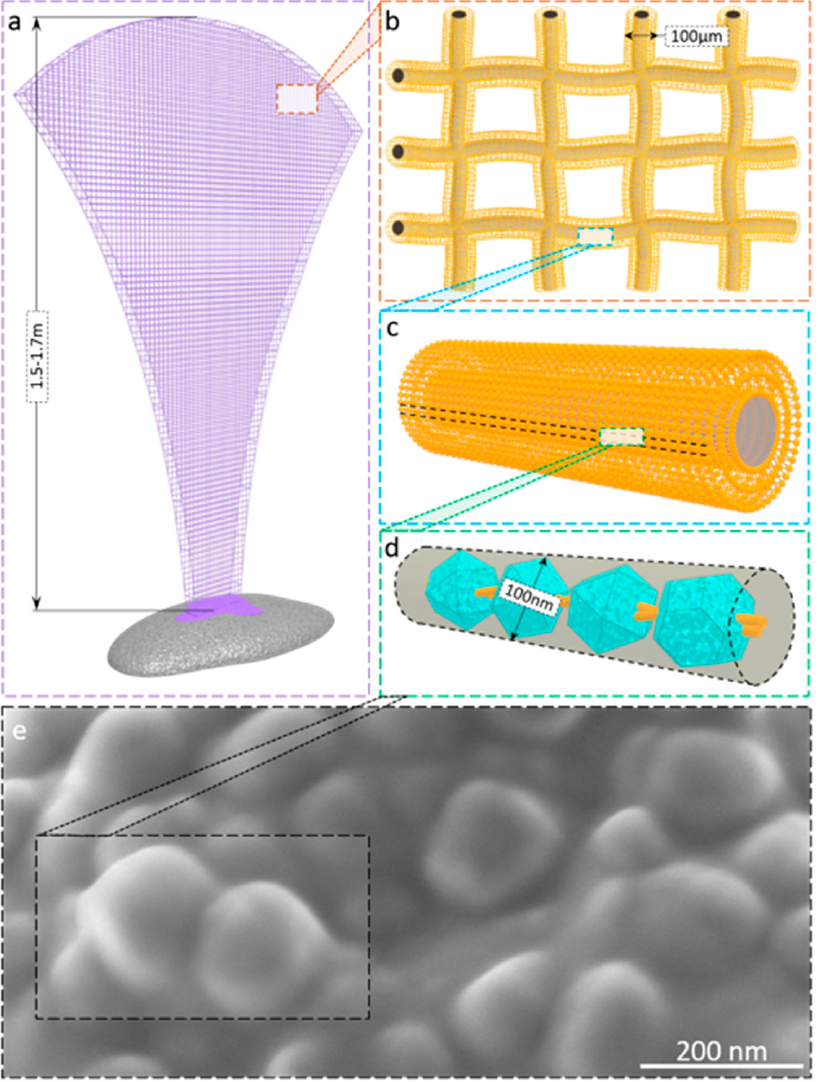
Figure 10. Schematic representation of mineralized giant network-like skeleton of I. basta marine demosponge ( a ). The flat construct is made of highly organized intercalated meshes of microfibers with a diameter of 100 µ m ( b ). These fibers are made of nanostructured chitin ( c ) that plays the role of template for the formation of calcitic nanocrystals ( d ), which remains well visible using SEM ( e ). The origin of calcium that is necessary for the formation of calcite in our case is unclear. It could be from surrounding seawater, or the rocky substrate as this sponge is able to dissolve it during ontogenesis using an enzymatic reaction (carbonic anhydrases- based) similar to that of calcite producing adhesive diatoms [49]. The presence of calcite in chitinous fibers seems to be reasonable: incorporation of this nanocrystalline biomineral phase into I. basta demosponge skeleton appears to be selectively favored because the resulting biological material becomes much more rigid than mineral-free skeletons